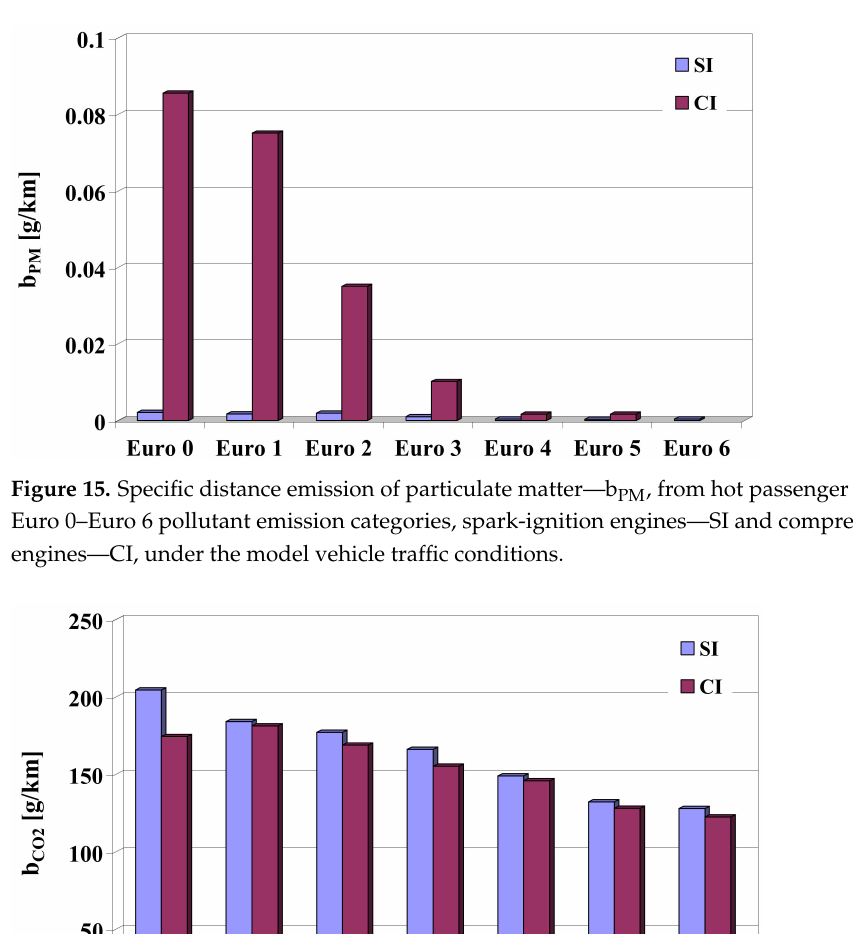
Figure 14. Specific distance emission of nitrogen oxides—b NOx , from hot passenger car engines of Euro 0–Euro 6 pollutant emission categories, spark-ignition engines—SI and compression-ignition engines—CI, under the model vehicle traffic conditions.